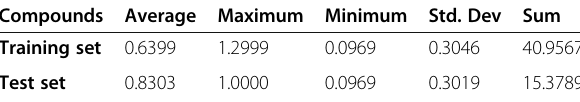
Table 2 Unicolumn statistics of activity (pIC 50 ) for training and test set compounds for G-QSAR Compounds Average Maximum Minimum Std. Dev Sum Training set